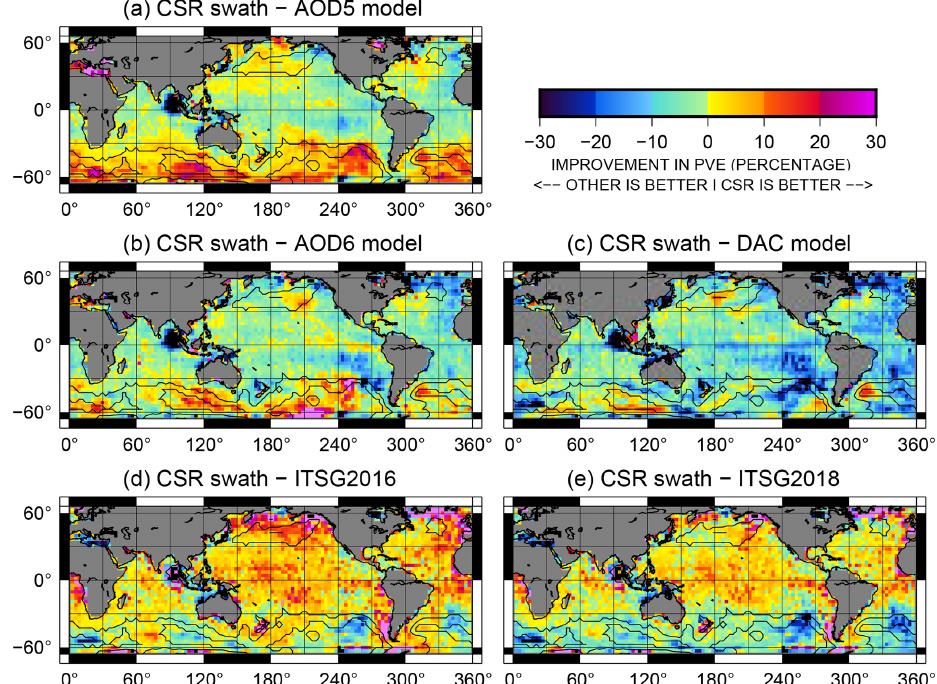
Figure 4. Differences in sub-monthly PVE for CSR swath vs. another data type: (a) AOD5 de-aliasing ocean model, (b) AOD6 de-aliasing ocean model, (c) altimetry DAC de-aliasing ocean model, (d) ITSG2016 GRACE data, and (e) ITSG2018 GRACE data. Values are relative to CSR swath PVEs, so positive numbers (red) denote that the CSR swath matches altimetry better, while negative numbers (blue) denote that the other series matches altimetry